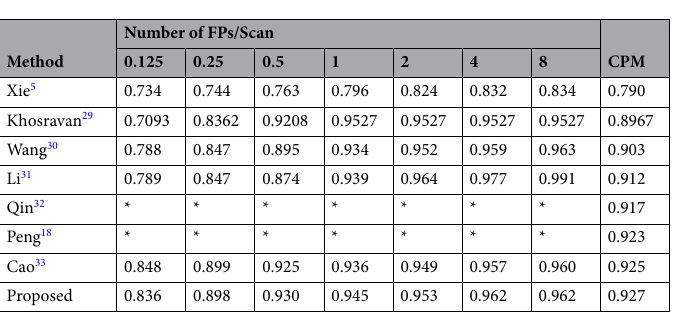
Table 4. Performance comparison of different methods for false positive